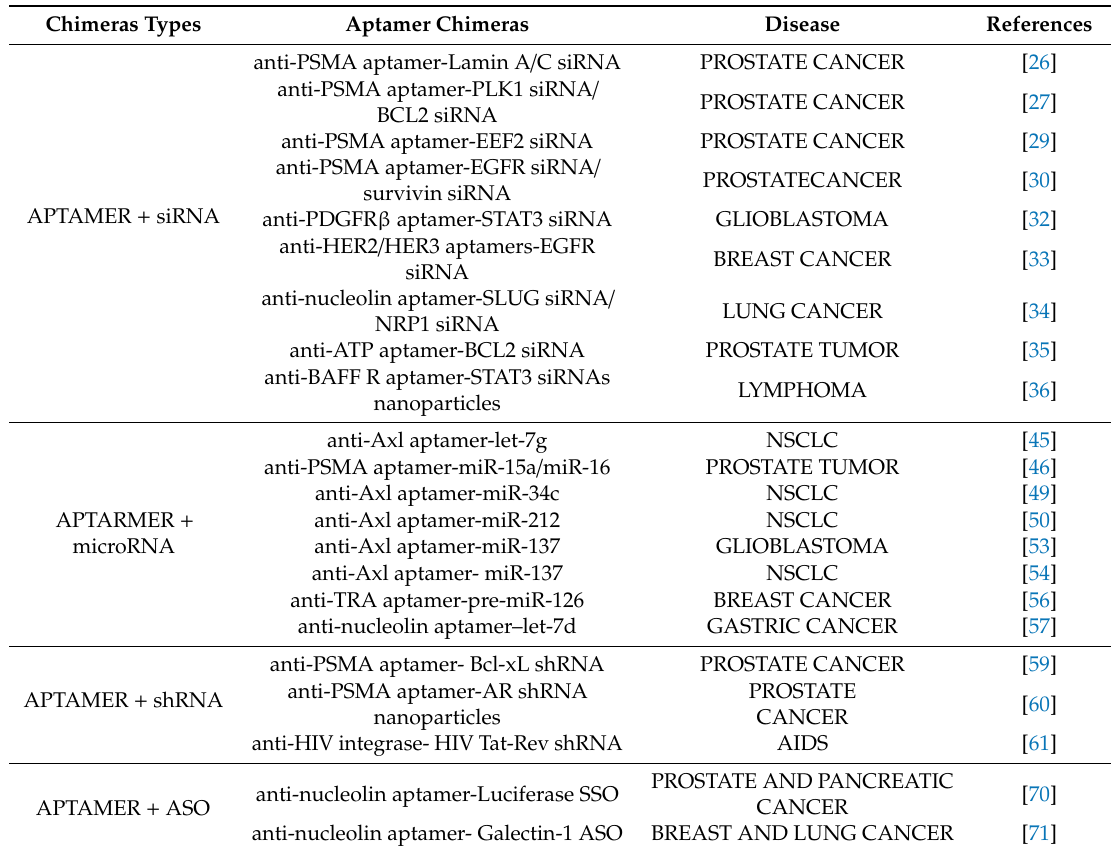
Table 1. Avaible aptamer-ODN conjugates. Examples of aptamer-chimera conjugates available as